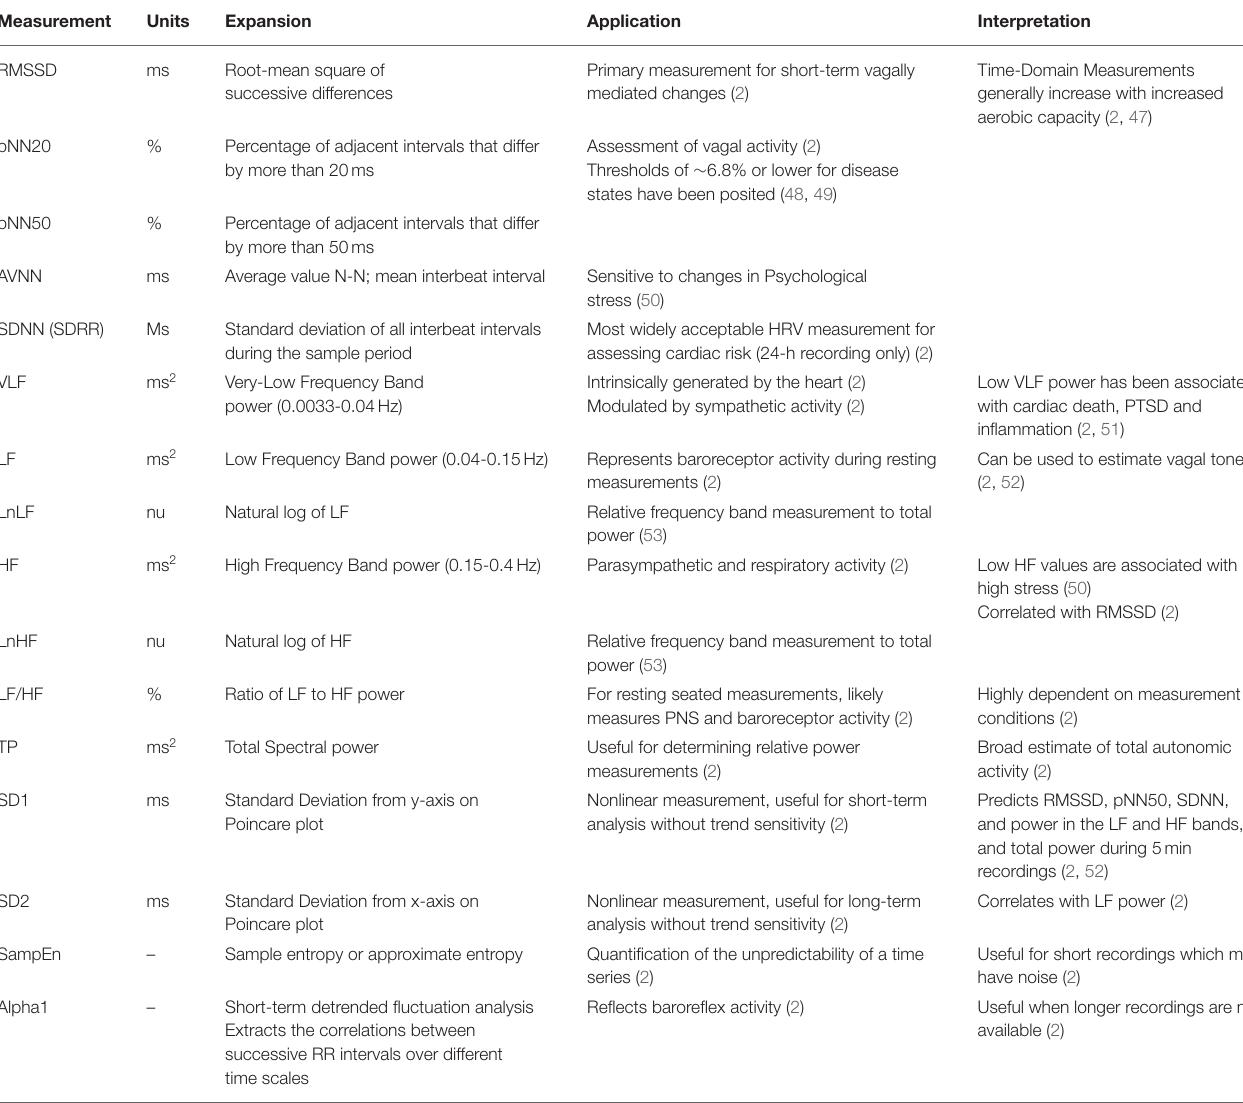
TABLE 3 | Expansion and definition of HRV measurement